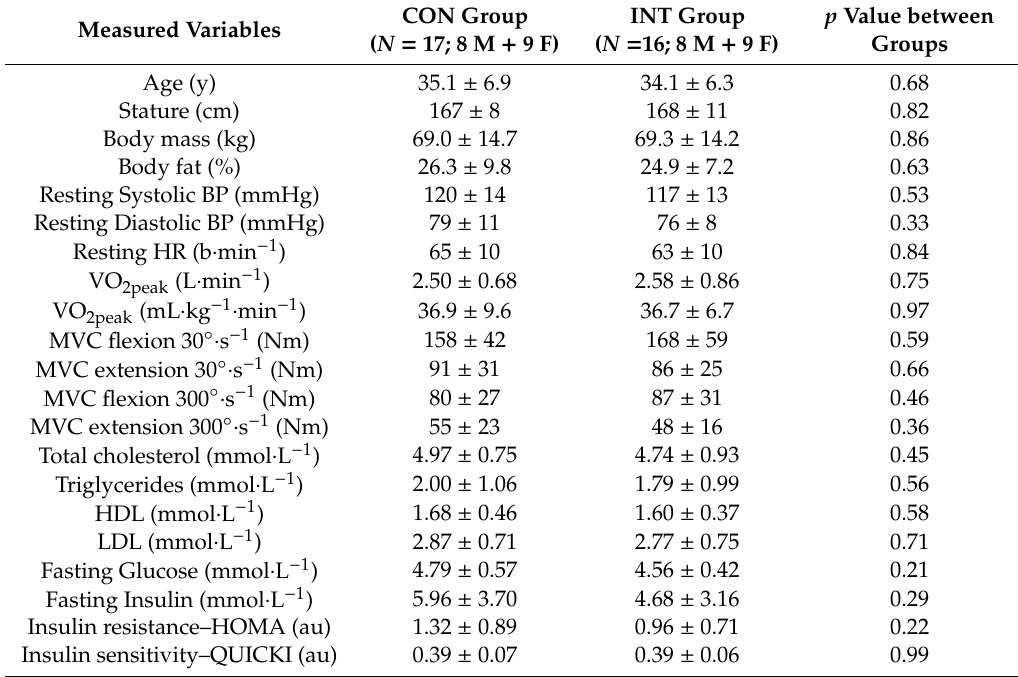
Table 3. Baseline characteristics and measures between the two groups in the study.